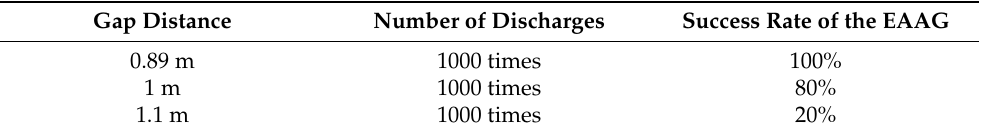
Table 2. Data from the insulation coordination